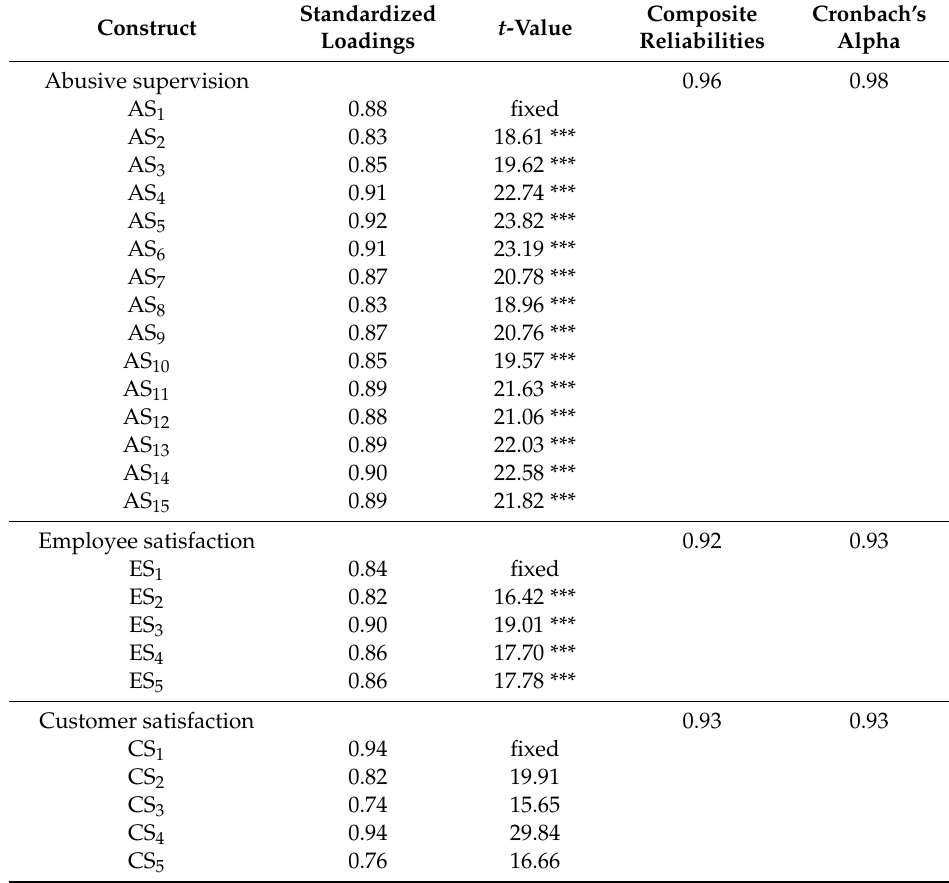
Table 2. Reliabilities and confirmatory factor analysis